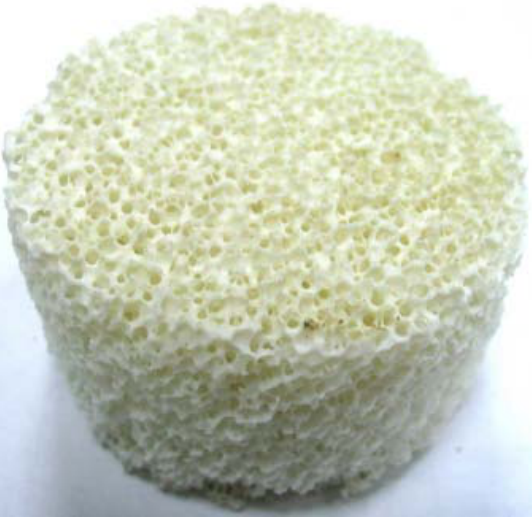
Fig. 1. Photo of sedimentation from high porosity material